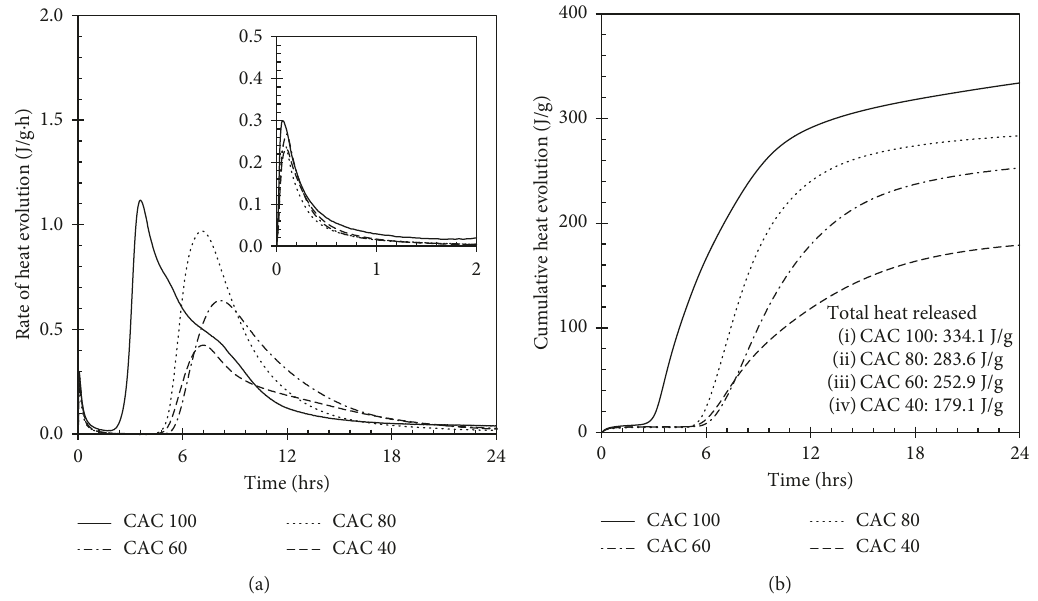
Figure 2: Calorimetric curves for CAC-GGBS mixtures with 0.4 of W/B ratio at an isothermal of 35 ° C for 24 hours: (a) rate of heat evolution; (b) cumulative heat evolution.